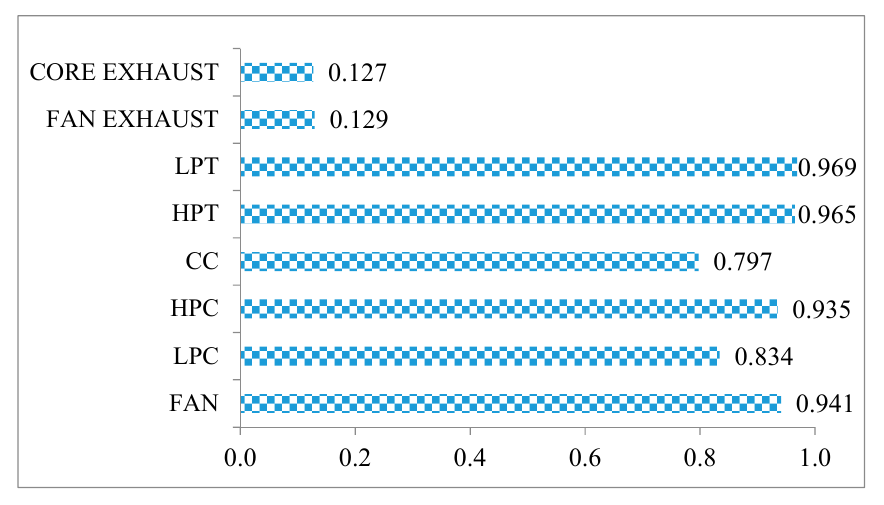
Figure 14. Exergy efficiency of the engine components.